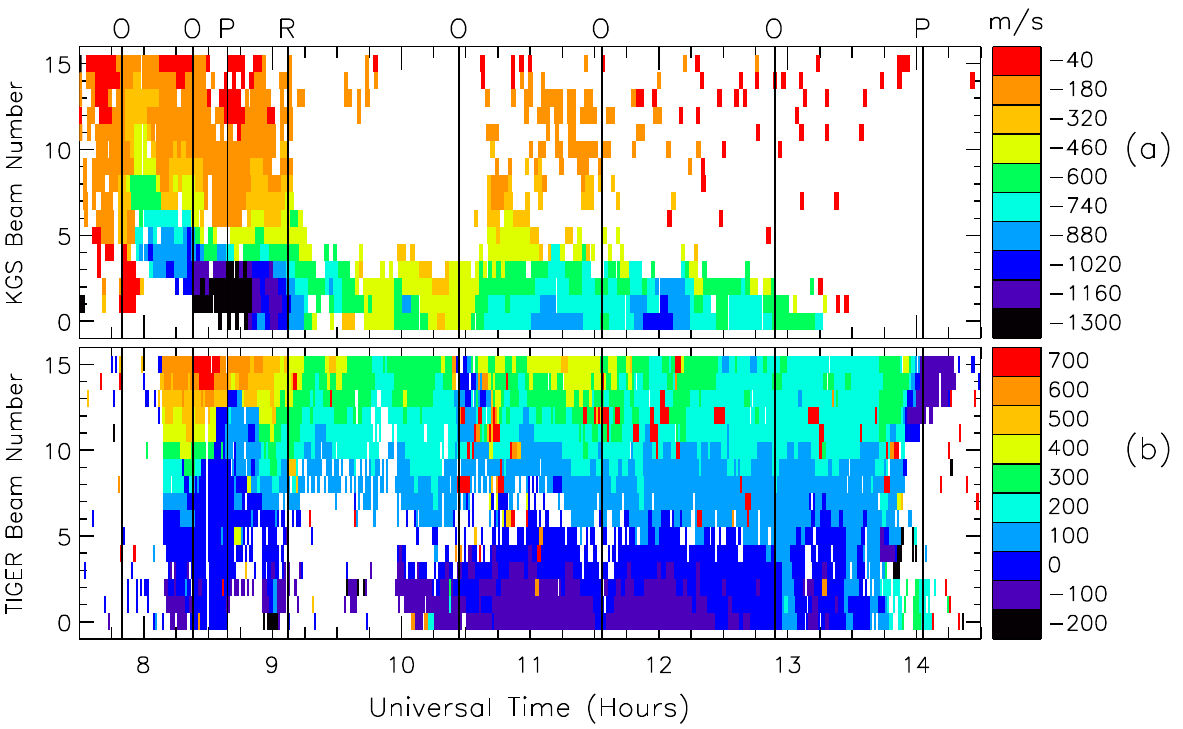
Fig. 8. (a) The maximum LOS speed found with the latitude range 61 ◦ to 65 ◦ 3 for all 16 beams of the KGS radar. For the lowest beam numbers (0 to 4), this latitude range tended to select peak speeds within the scatter associated with the AWFC. (b) The same except for all 16 beams of the TIGER radar. Similarly, for the highest beam numbers (11 to 15), this latitude range tended to select peak speeds within the scatter associated with the